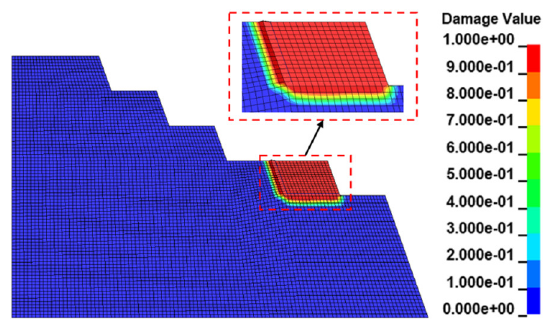
Figure 3. Cloud image showing the slope damage results.